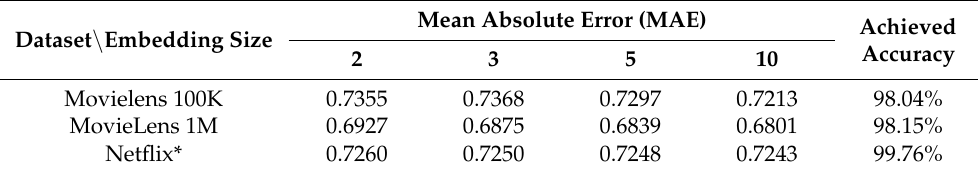
Table 2. Mean absolute error results using the proposed variational Euclidean method (embedding sizes = 2, 3, 5, 10 and the comparative accuracy obtained by setting an embedding size 2 versus an embedding size 10. The lower the MAE values, the better the